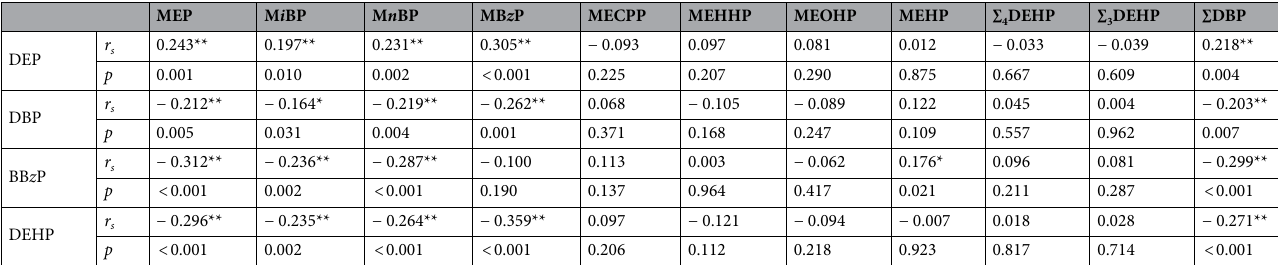
Table 3. Spearman ranks correlations between the levels of eight phthalate metabolites (µg/L) in the urine of preterm neonates receiving daily TPN solutions during their stay in the NICU and the levels of phthalate compounds in TPN solutions. **Correlation is significant at the 0.01 level (2-tailed); *Correlation is significant at the 0.05 level